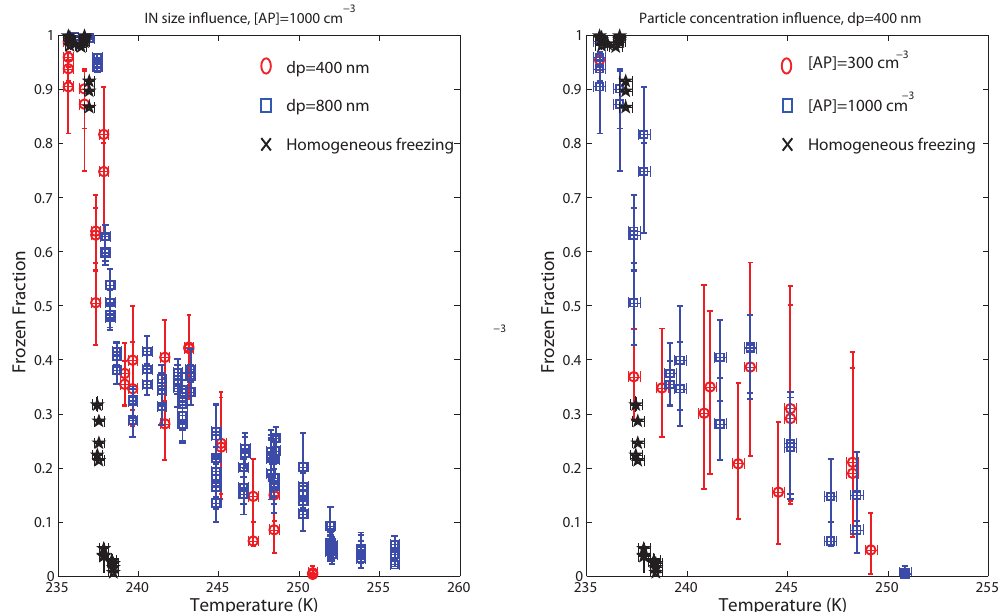
Fig. 11. Experimental frozen fraction on contact freezing as a function of temperature conducted in CLINCH. The cloud droplets have a residence time of 5s. The left panel shows the comparison of two different particle sizes and the right panel the comparison of two different aerosol particle concentrations. The black stars represent the homogeneous freezing data. dp refers to the aerosol particle diameter and [AP] to the aerosol particle